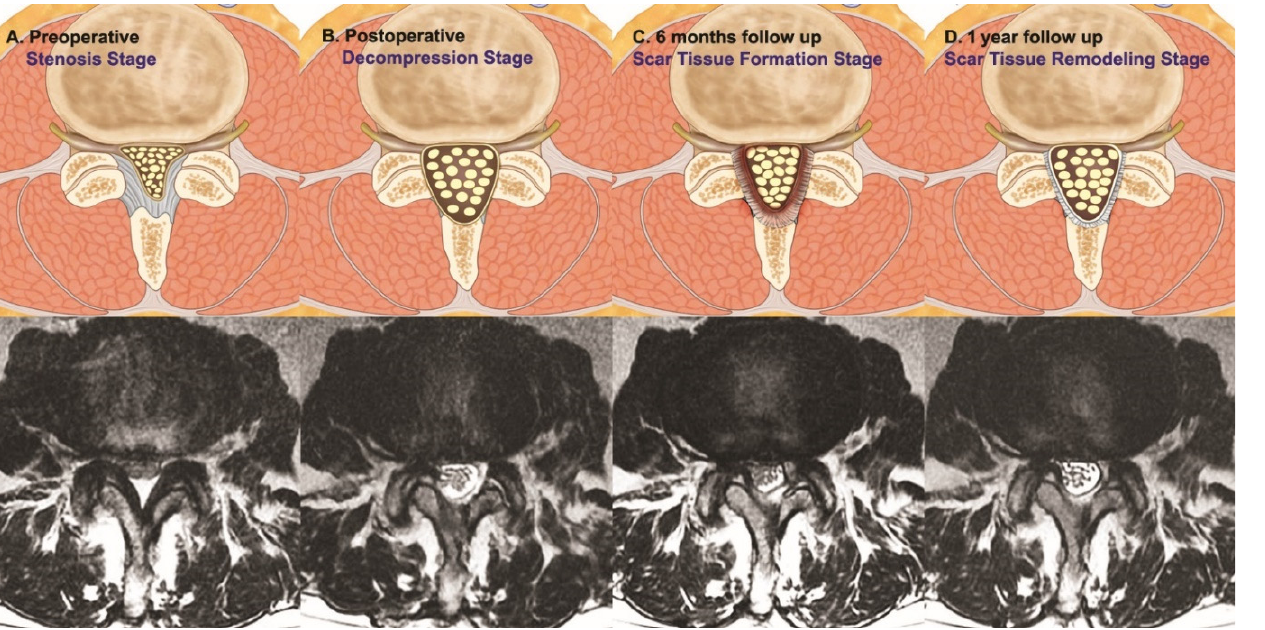
Figure 9. Distribution pie chart of the various types of spinal canal remodeling pattern after lumbar endoscopic unilateral laminotomy with bilateral decompression (LE-ULBD). Type A: continuous expanded spinal canal, type B: restenosis with delayed expansion, type C: progressive expansion and type D: restenosis.